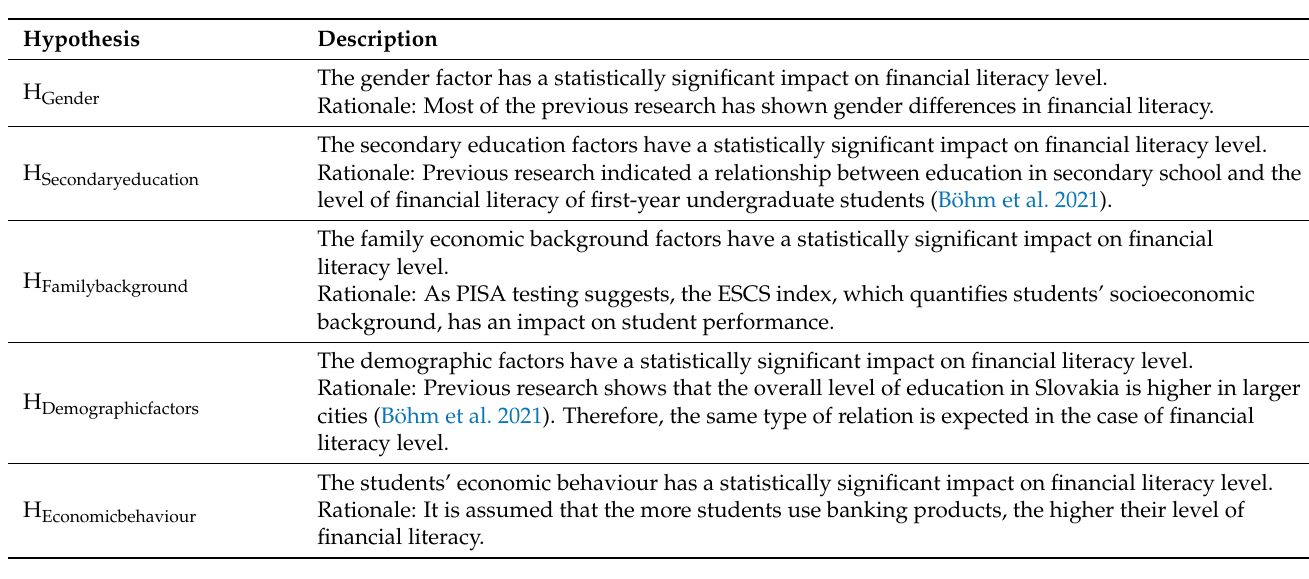
Table 2. List of research